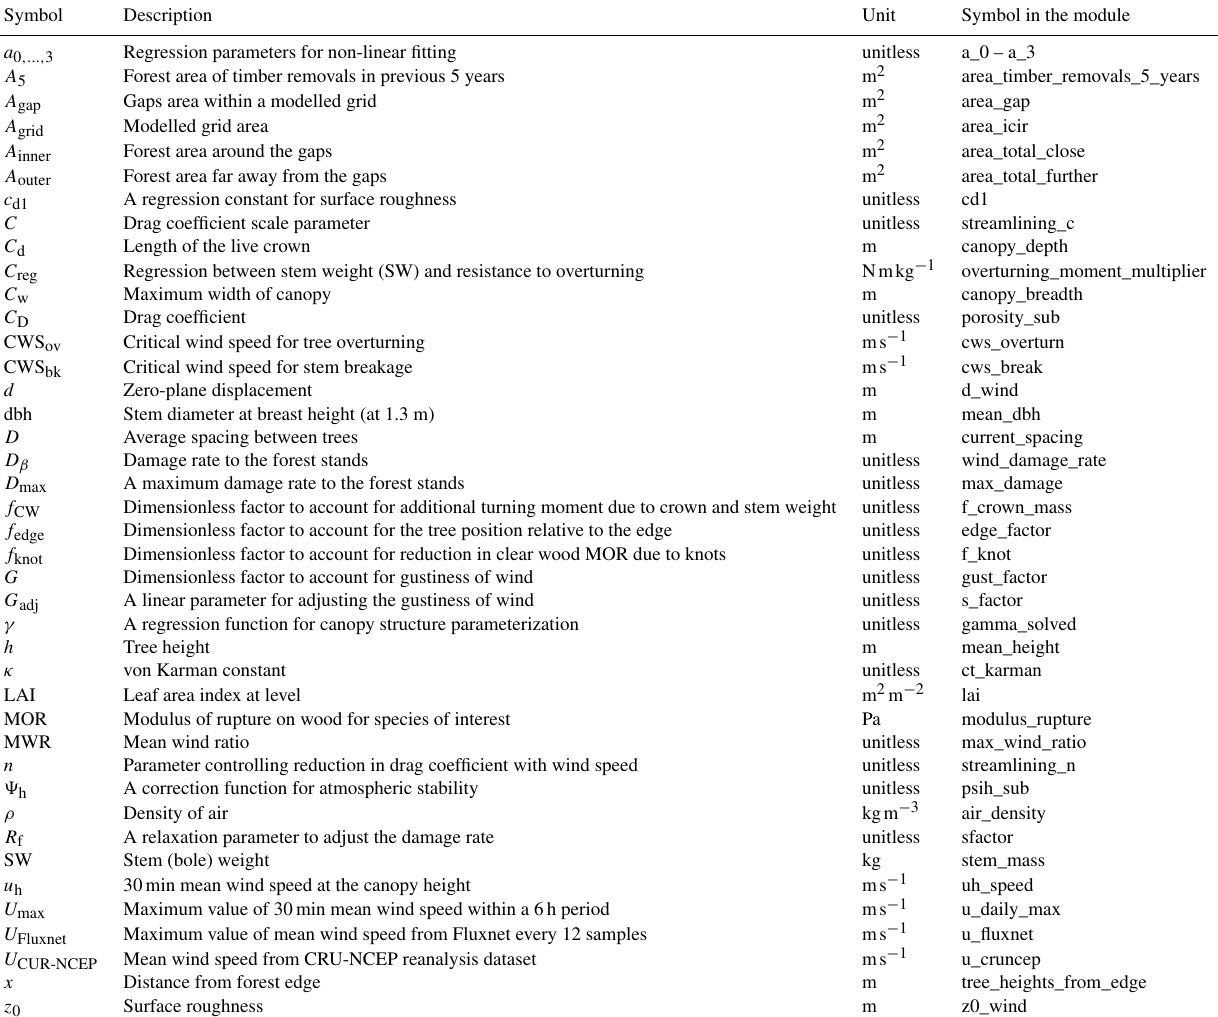
Table 1. Symbolic notation used throughout the paper. Symbol Description Unit Symbol in the module a 0 ,...,